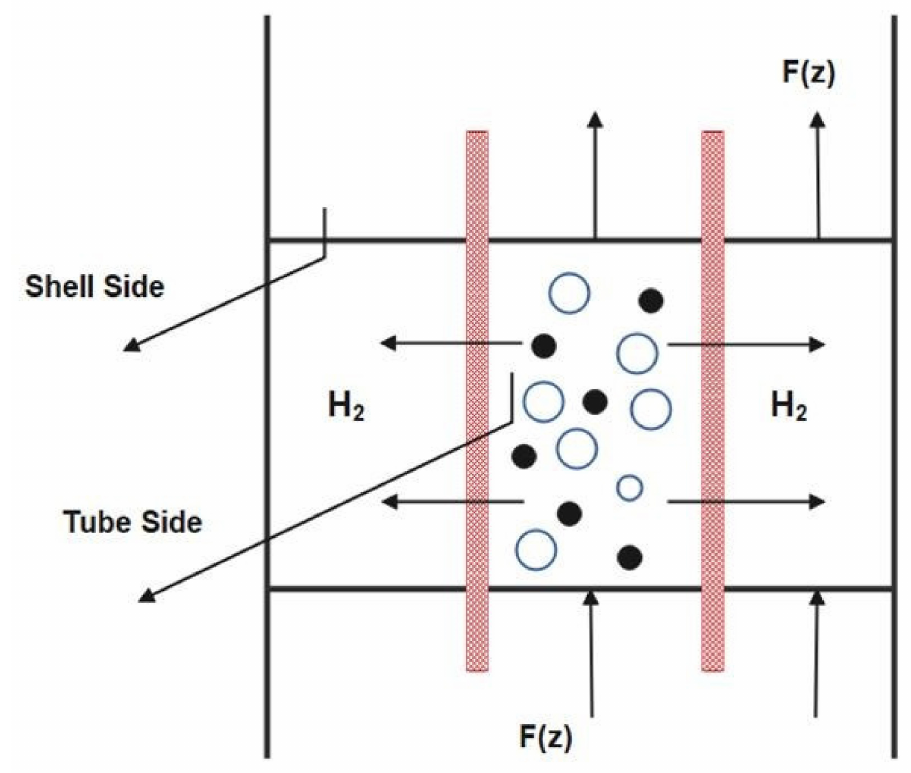
Figure 2. Cross sectional view of Fluidized bed membrane reactor